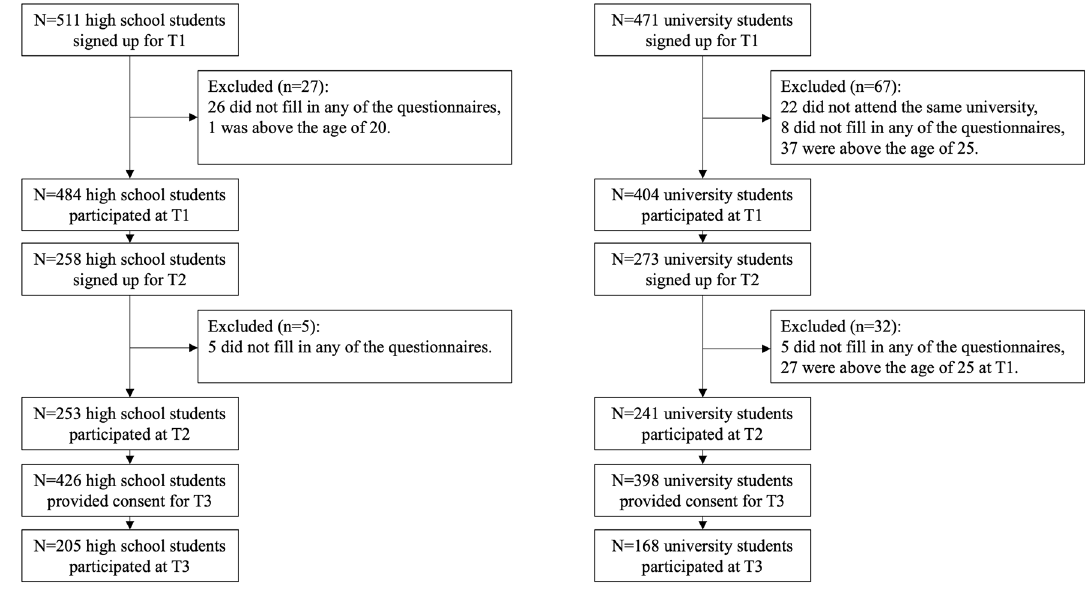
Figure 1. Flowchart of